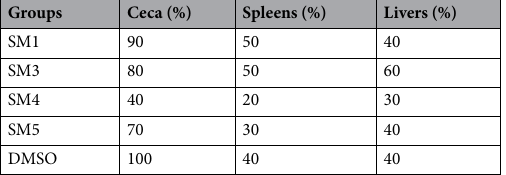
Table 4. Tissues positive for Salmonella enterica subsp. enterica serotype Typhimurium after enrichment following treatment with small molecules